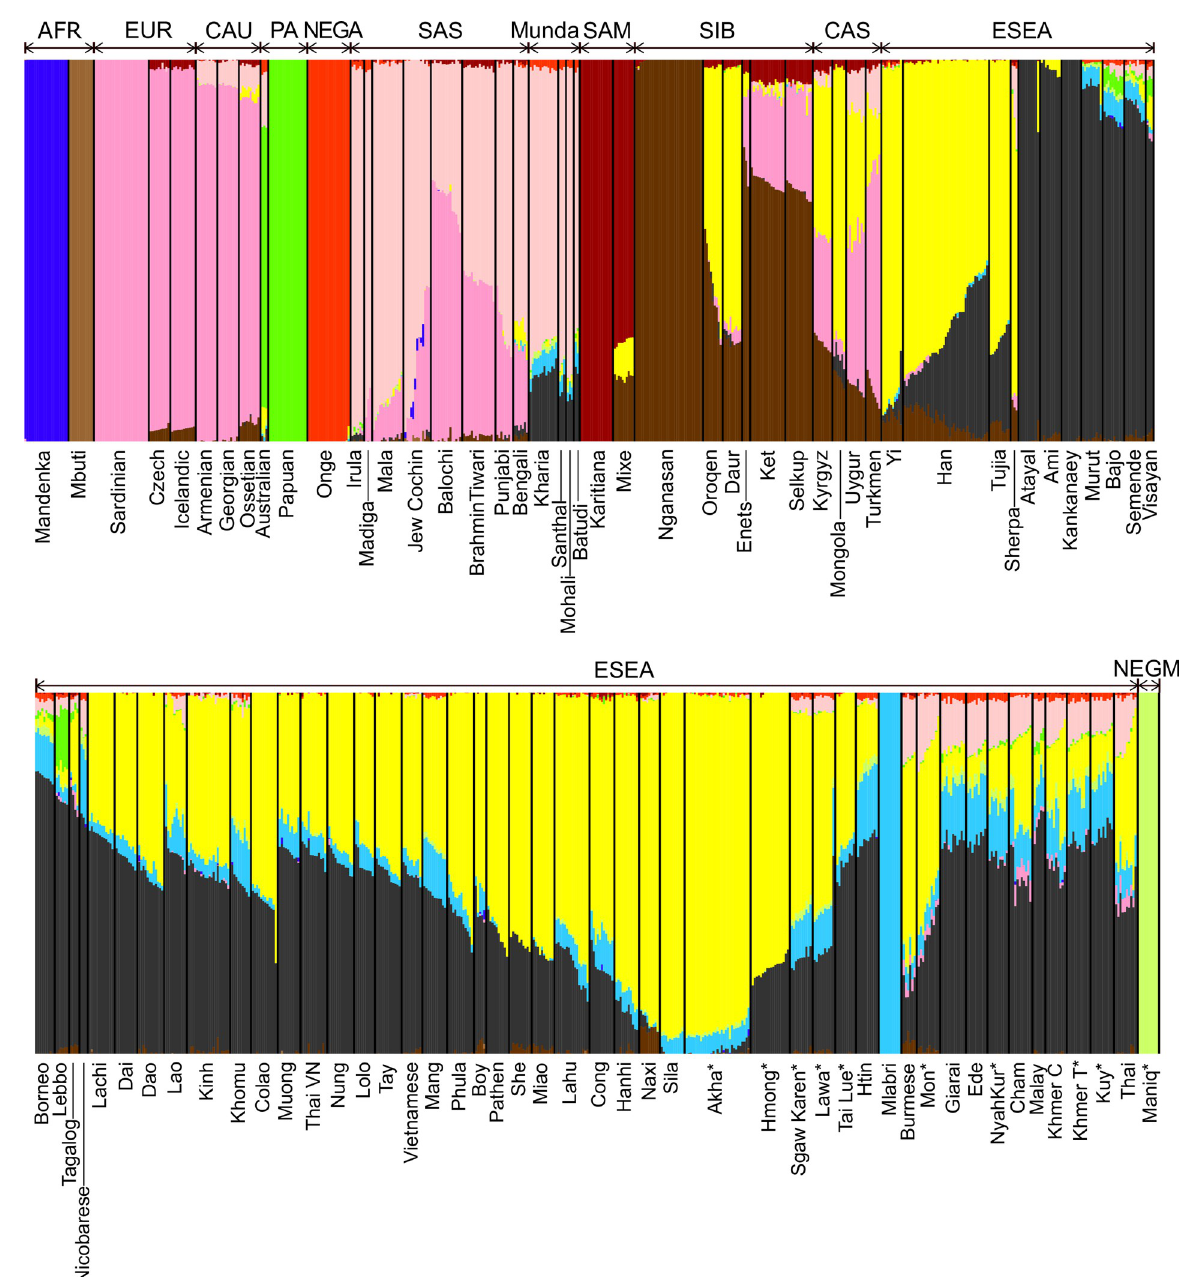
Fig 3. Results of an ADMIXTURE analysis. The plot represents results for 12 hypothetical ancestral populations. Abbreviations of meta- populations are shown above the plot: AFR, Africans; EUR, Europeans; CAU, Caucasians; PA, Papuans and Australians; NEGA, Andamanese Negritos; SAS, South Asians; Munda, Austroasiatic-speaking populations (the Munda branch) from India; SAM, Native South Americans; SIB, Siberians; CAS, Central Asians; ESEA, East and Southeast Asians; and NEGM, Mainland Negritos. Asterisks after population names indicate that these populations are newly genotyped in this